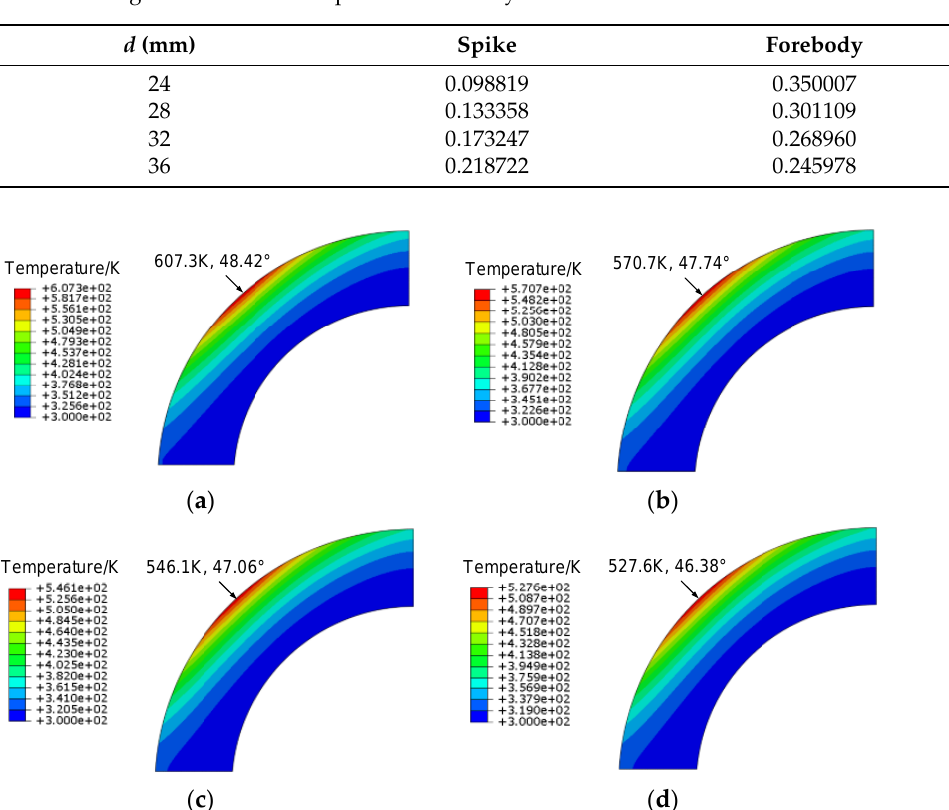
Table 12. Drag coefficients of the spike and forebody.